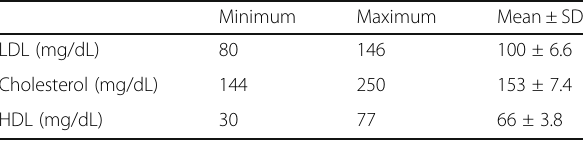
Table 1 Lipid profile of group I